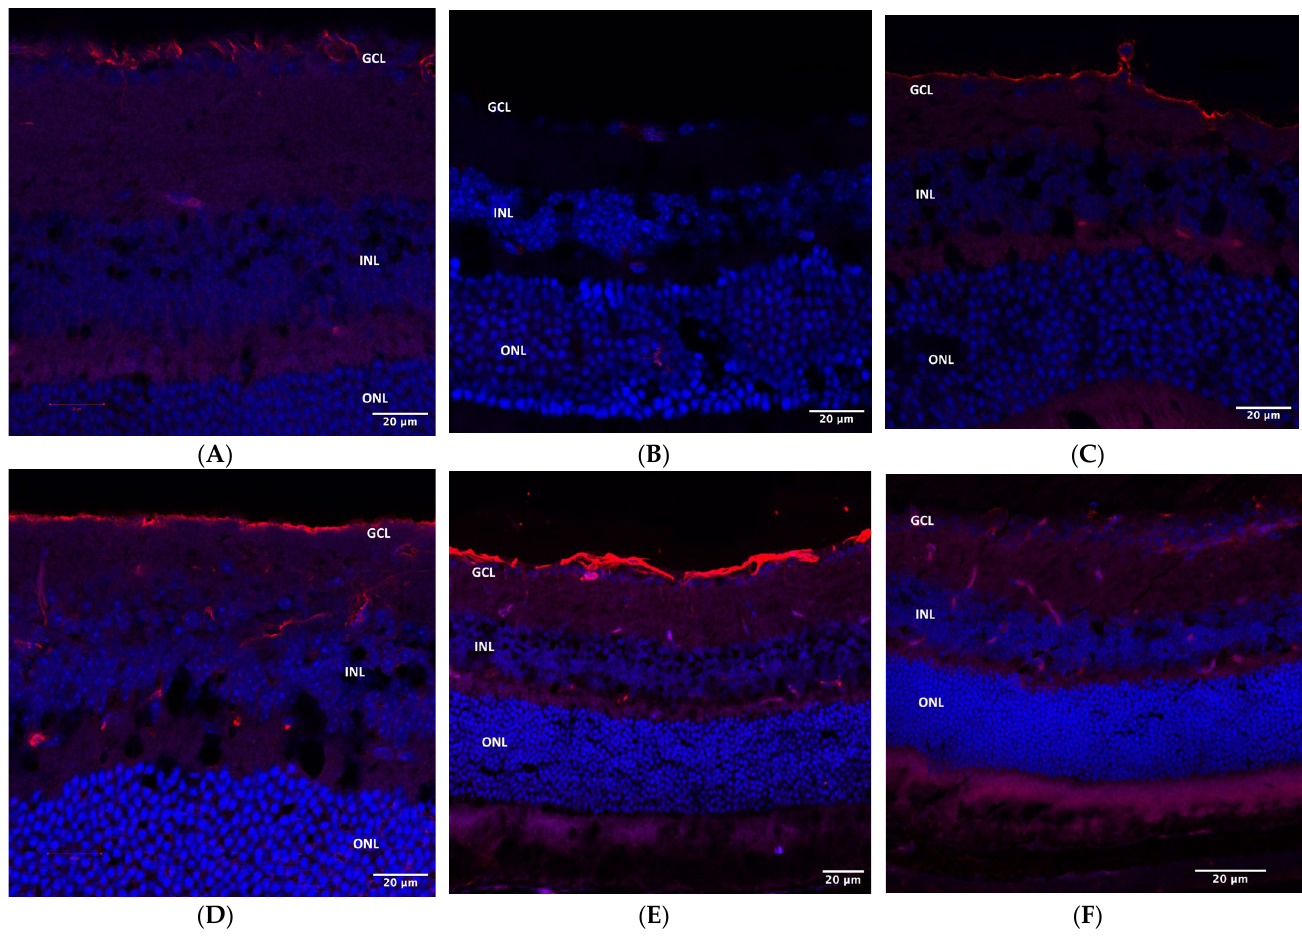
Figure 7. GFAP staining. ( A ) GFAP staining is positive (21.4 RFU) in the right eye of WT microbead- injected eyes. ( B ) GFAP staining is negative (2.79 RFU) in left control eyes. ( C ) WT microbead-injected eyes treated with IP sildenafil showing positive GFAP staining (17.17 RFU). ( D ) Moderate GFAP staining (34.62 RFU) observed in WT microbead-injected eyes treated with AZ. ( E ) TLR4KO microbead-injected eyes treated with AZ showing evident staining (62.685 RFU). ( F ) Minimal staining (14.4 RFU) is seen in TLR4KO left control eyes. GFAP, red; DAPI, blue. RFU, relative fluorescence units; WT, wild type; IP, intraperitoneal; AZ, azithromycin; TLR4KO, toll-like receptor 4 knockout. Iba1 staining demonstrated microglia activation in the ganglion cell and inner nuclear layers (GCL and INL) in AZ-treated microbead-injected eyes (Figure 8A) but not in control eyes (Figure 8B). In situ TdT-mediated dUTP nick end labeling (TUNEL) assay in AZ-treated microbead- injected eyes showed a number of positive apoptotic cells in the RGC layer, suggesting RGC death following glaucoma induction (Figure